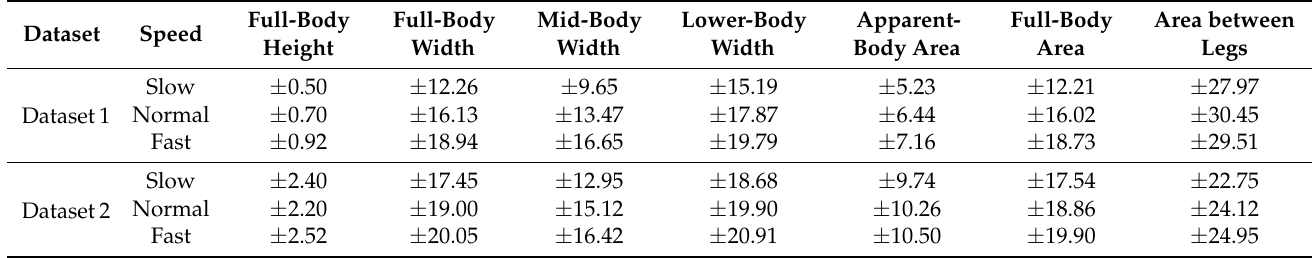
Table 4. Variation in the body measurements over consecutive frames at three walking speeds. This variation was calculated using the standard deviation (SD) from the mean over all image sequences and is presented in terms of percentages (%). Dataset